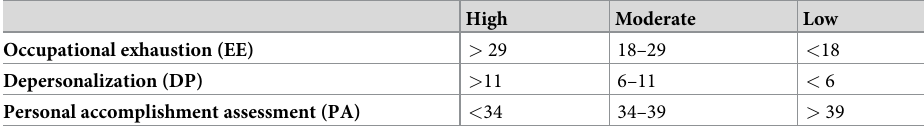
Table 1. Maslach burnout inventory